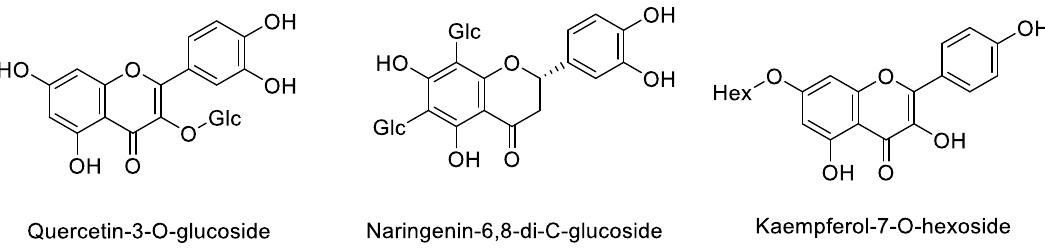
Chart 2. Main compounds identified in in B. retusa leaves and fruits. Table 3. Quantification of compound detected by LC-DAD-MS n in B. retusa leaves and fruit. Leaves